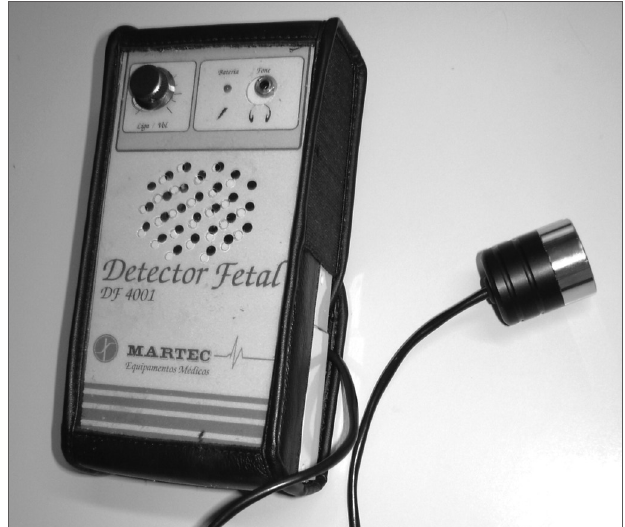
Figure 1. Sonar Doppler sonar